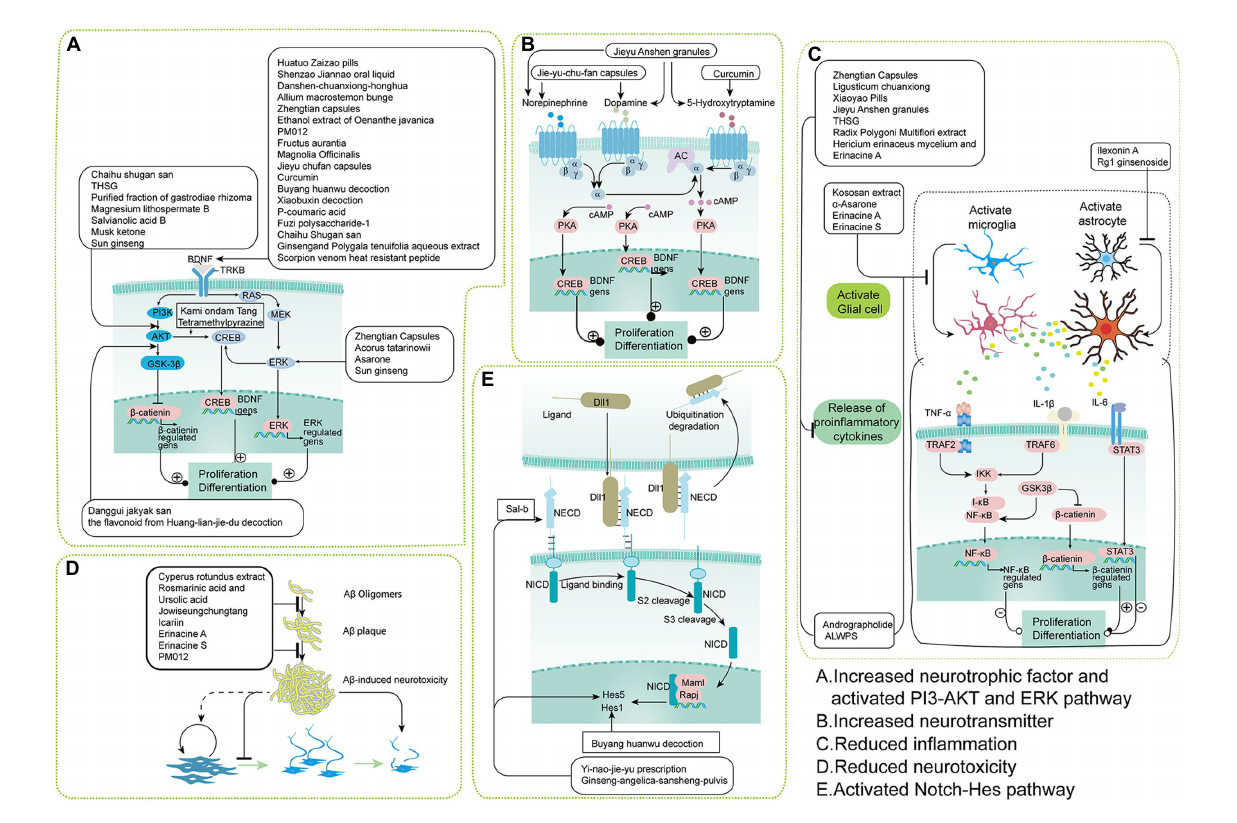
FIGURE 7 Mechanisms of TCMPs, CHMs, and bioactive components on adult neurogenesis. (A) TCM could increase neurotrophic factors or activate the PI3-AKT and ERK pathways for adult neurogenesis. (B) TCM could increase neurotransmitters for adult neurogenesis. (C) TCMs could reduce inflammation for adult neurogenesis. (D) TCM could reduce neurotoxicity for adult neurogenesis. (E) TCM could activate the Notch-Hes pathway for adult